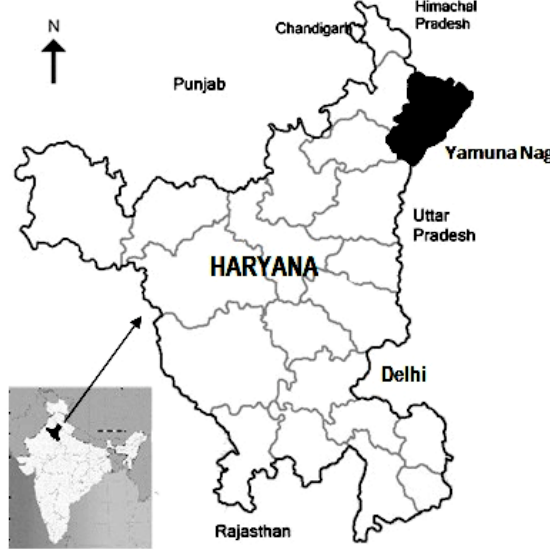
Figure 1. Location of Yamuna Nagar District in the Haryana State